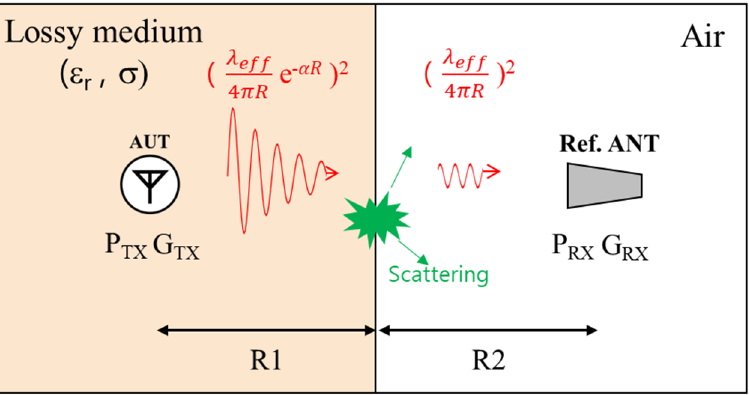
Figure 1. Illustration of conventional gain comparison method which evaluates radiation characteristics for antenna in lossy media.